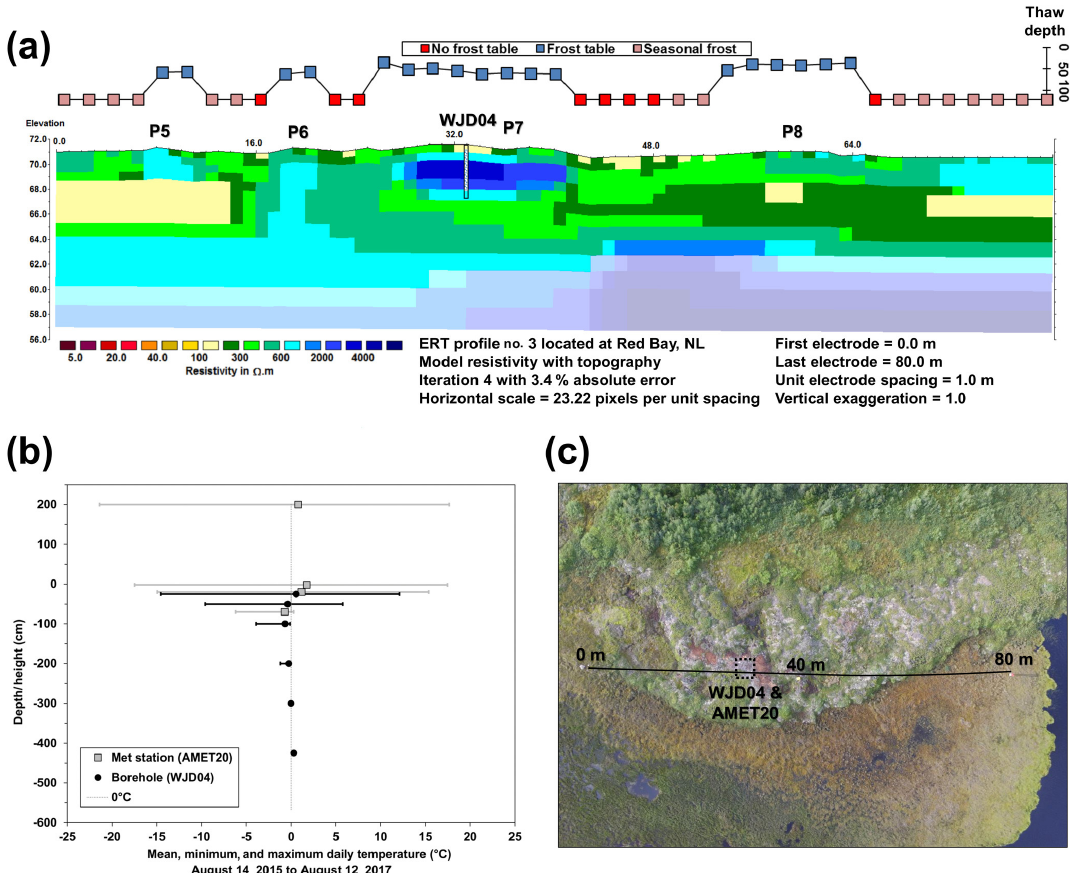
Figure 4. Peatland permafrost at Red Bay. (a) Frost tables and modelled resistivities on ERT profile 3. Depths with permafrost in borehole WJD04 are denoted by hatching. (b) Air and ground temperature envelopes (2015–2017). (c) UAV vertical image of the site. Black line delimits the approximate location of the ERT survey line and text shows the start and end